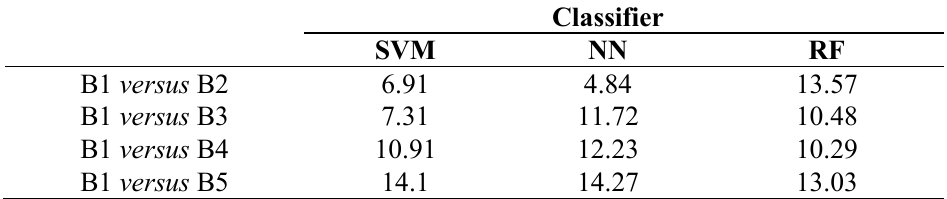
Table 10. Z-test * results for the comparison of overall accuracies of B1 versus B2–B5. See Table 5 for the descriptions of